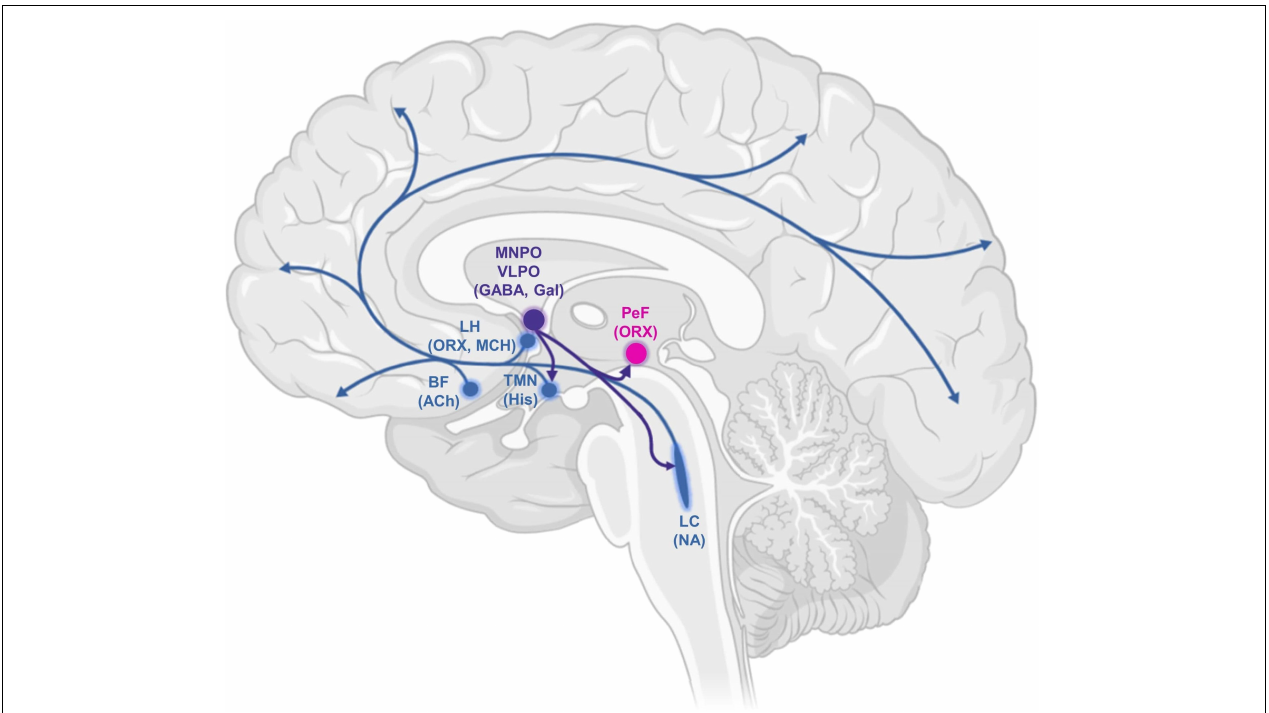
FIGURE 1 | Schematic drawing of some key components of the ascending arousal system, highlighting projections of the ventrolateral preoptic area. This comprises cortical projection neurons originating from the basal forebrain (BF); the recently characterised orexin/hypocretin neurons in the lateral hypothalamus (LH); perifornical orexin neurons (PeF); and several monoaminergic nuclei: the noradrenergic locus coeruleus (LC), the histaminergic tuberomammillary nucleus (TMN) and the ventrolateral preoptic area (VLPO) and median preoptic area (MNPO). Serotonergic and dopaminergic components are not shown. MCH, melanin-concentrating hormone; Gal, galanin; Ach, acetylcholine; ORX, orexin; His, histamine; NA,